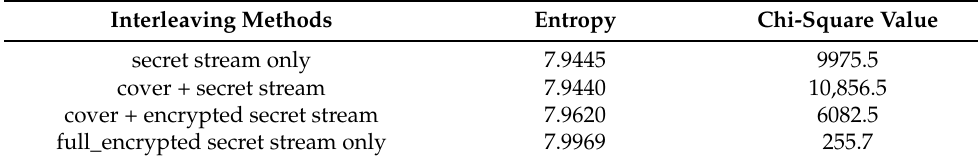
Table 3. Comparison of plausibility of several